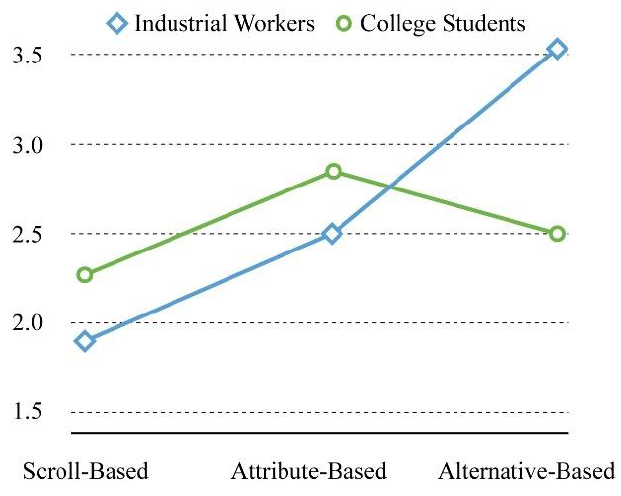
Figure 6. The interaction diagram regarding mental demand.